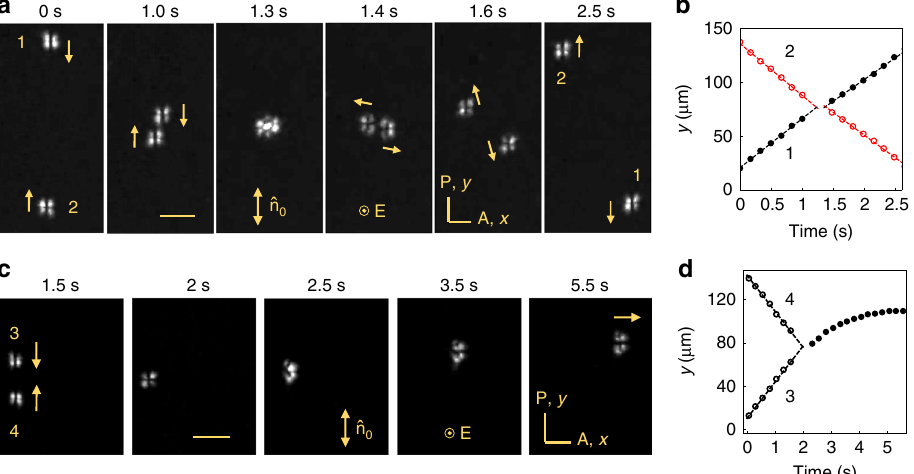
solitons. a Collision of two B l solitons ( “ 1 ” and “ 2 ” ); voltage 8.0 V, frequency 20 Hz, scale bar 30 µ m. b Dynamics of the y -locations Fig. 8 Collisions of B l 0 0 of the solitons shown in a . c Two B l solitons ( “ 3 ” and “ 4 ” ) collide and transform into a single B l 0 d Dynamics of the y -locations of the solitons shown in